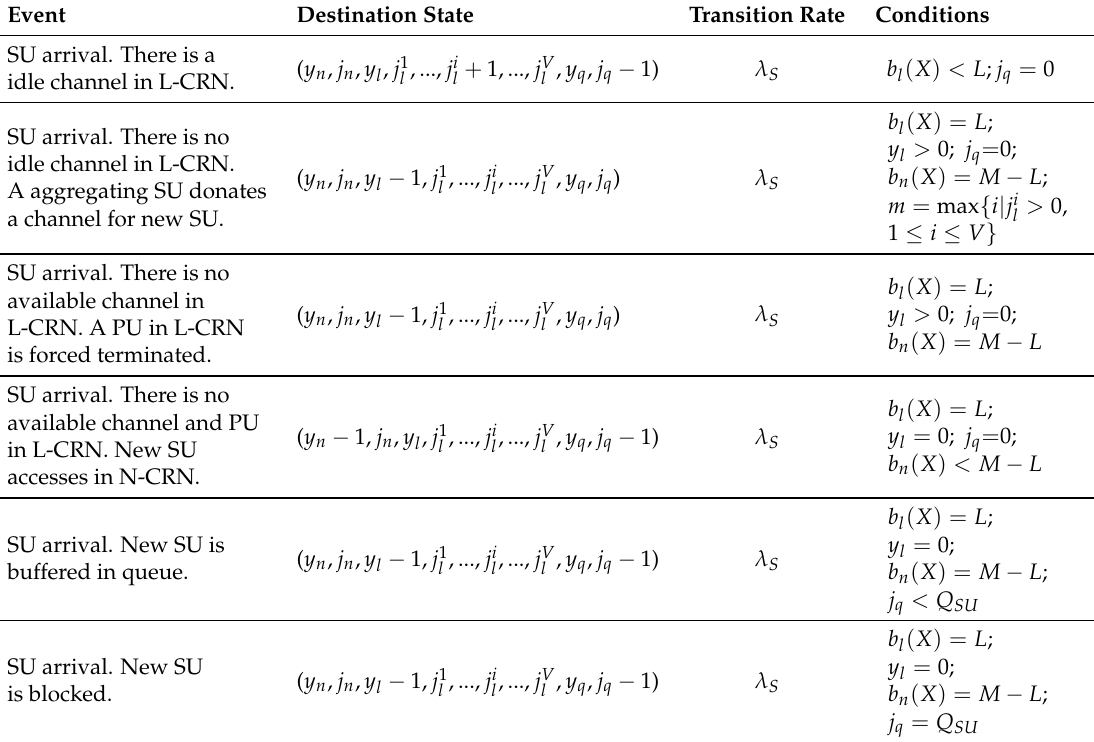
Table 3. Transitions of DFSL when a SU arrives.